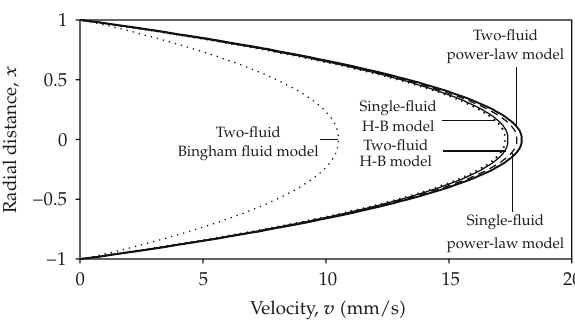
Figure 2: Velocity distribution at the middle of the stenosis at t (cid:7) 0.5 for di ff erent fluid models with α (cid:7) 0.95, φ (cid:7) 0.1 ◦ , τ m (cid:7) 0.1 a , μ H (cid:7) 0.035, and μ N (cid:7) 0.3 μ H .